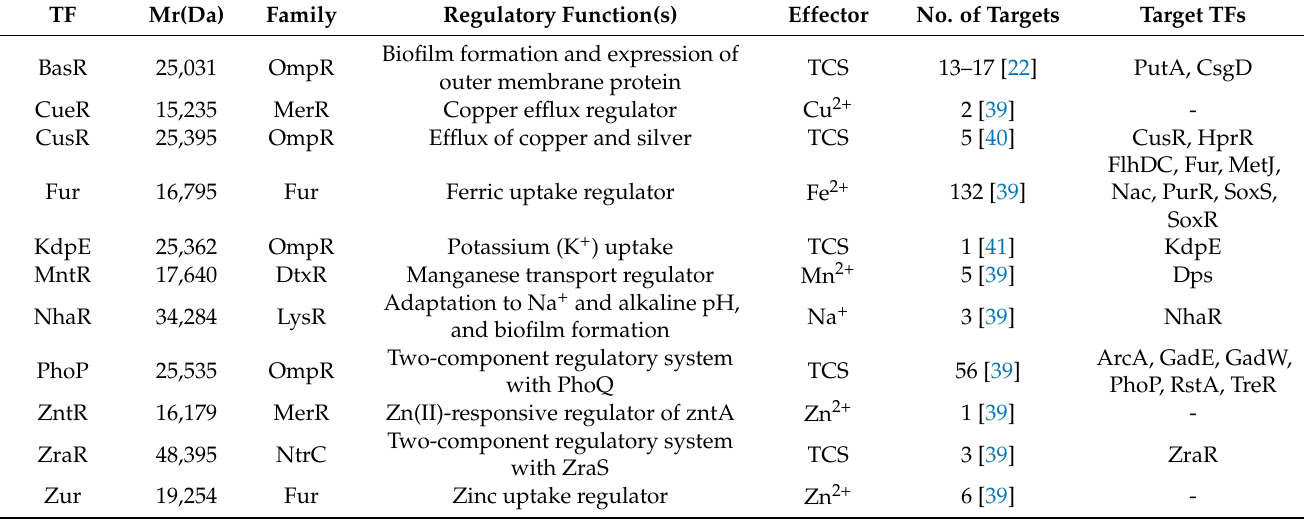
Table 1. Characteristics of the targeted transcription factors